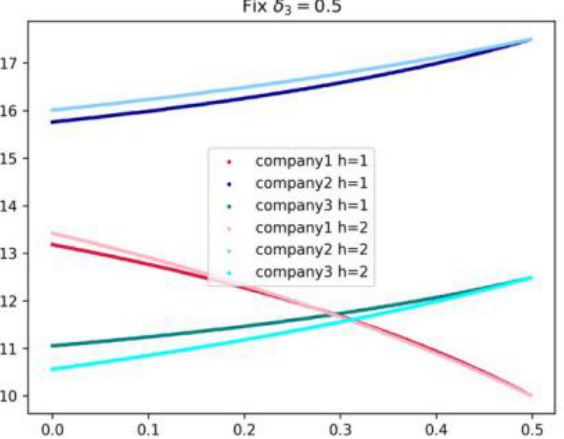
Figure 6. The result of the distribution of profits varies with δ 1 ( δ 3 is fixed).